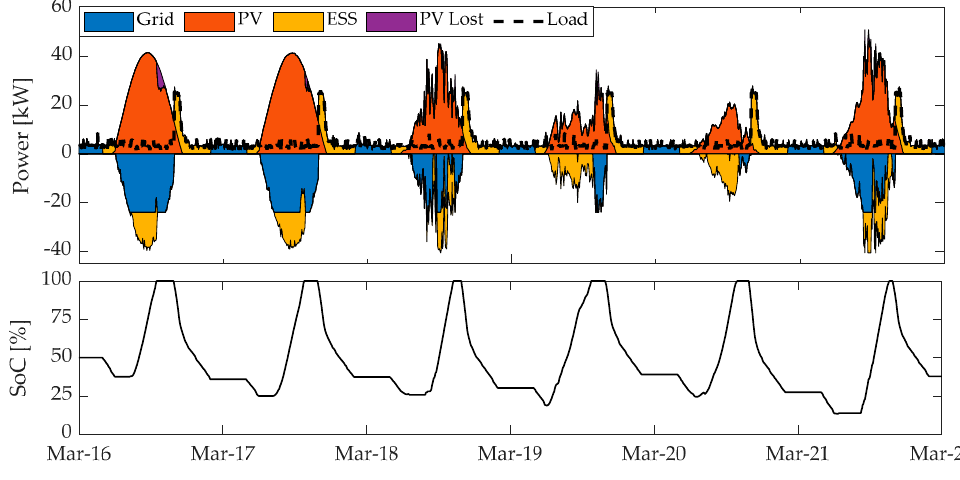
Figure 15. RBC3r strategy (reference).